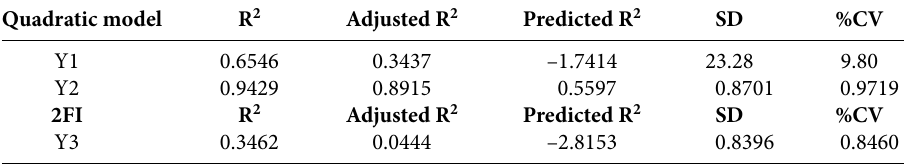
Table 8. Results of Quadratic and 2FI model for regression analysis of response variables Y1, Y2 and Y3. Quadratic